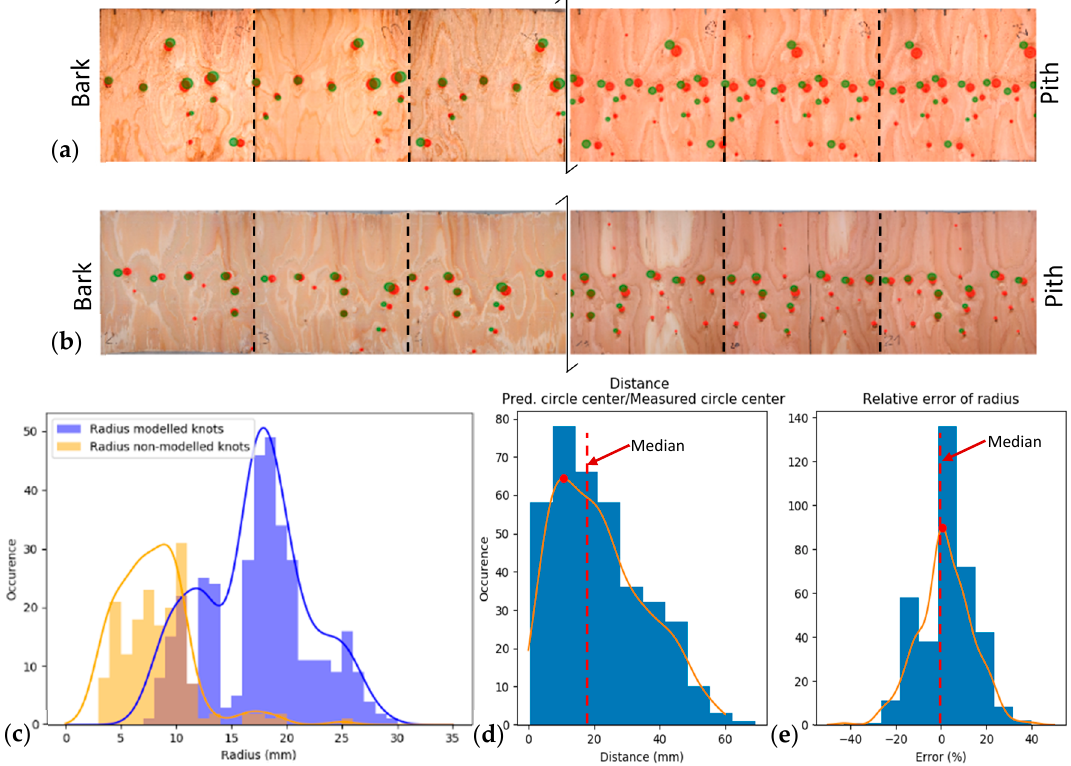
Figure 9. ( a ) Predicted knots in green and real knots in red for the first and last parts of the log 1 ribbon; ( b ) predicted knots in green and real knots in red for first and last parts of the log 2 ribbon; ( c ) knot radius histograms; ( d ) distance from predicted knot center to real knot center; ( e ) relative error of radius.